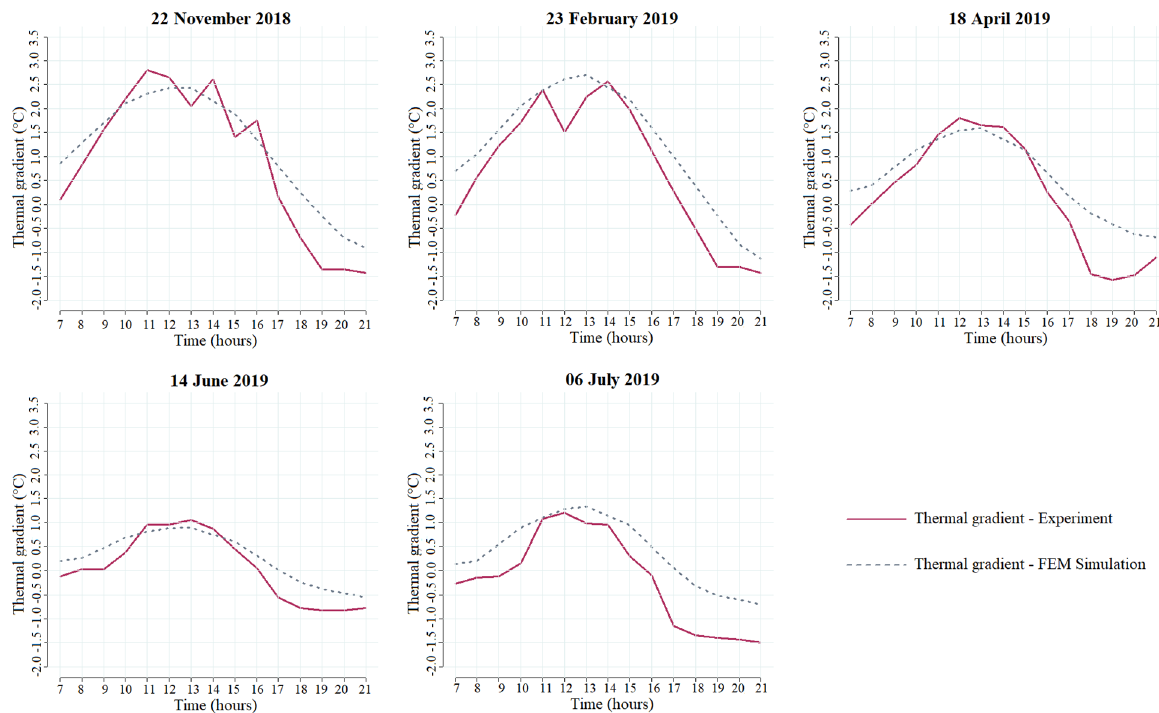
Figure 6. Comparison between thermal gradients obtained from the IRT experiment and simulated by the FEM.